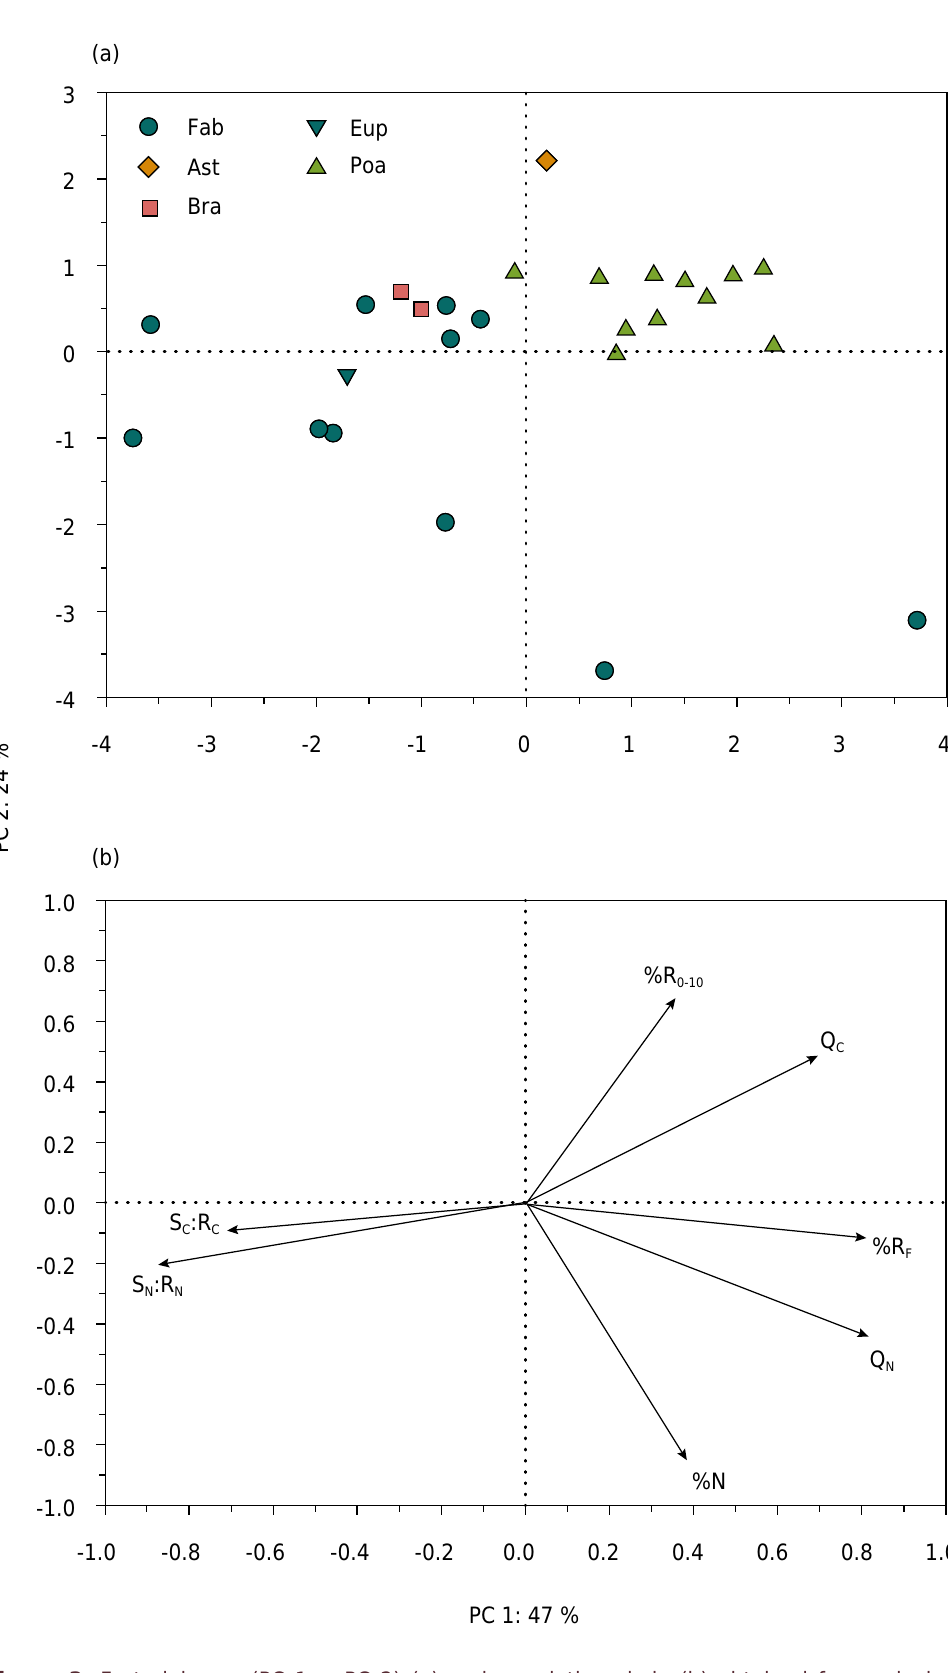
Figure 3. Factorial map (PC 1 × PC 2) (a) and correlation circle (b) obtained from principal component analysis (PCA) performed using data from the roots of 27 species: vertical distribution (%R 0.00-0.10 ), proportion of fine roots (%R F ), root C and N contents (Q C , Q N ), root N concentration (%N), and shoot:root ratio for N and C inputs (S N :R N and S C :R C ). Fab = Fabaceae; Poa = Poaceae; Ast = Asteraceae; Bra = Brassicaceae; Eup =